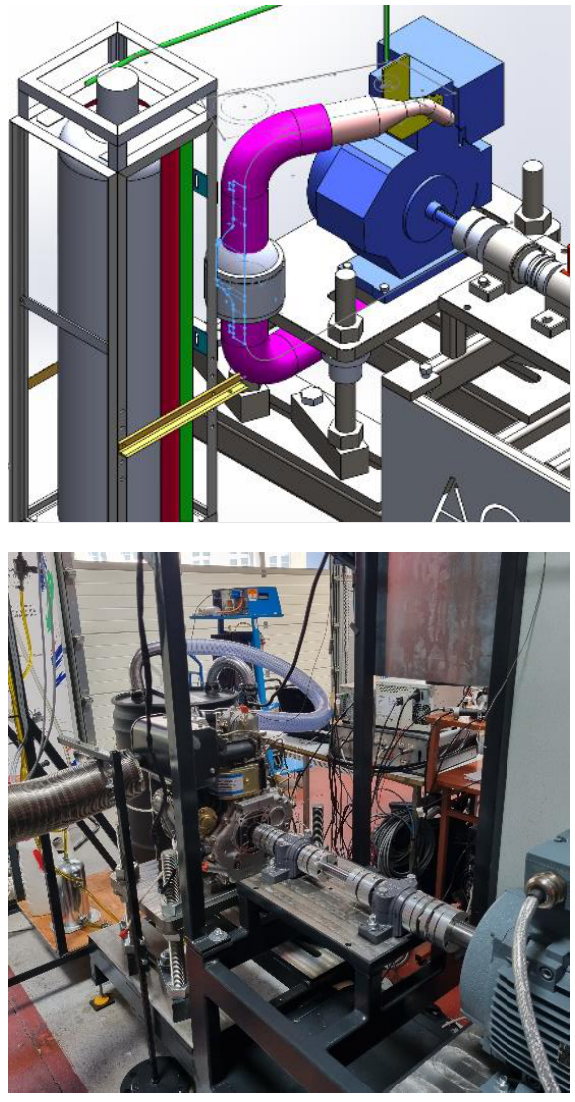
Fig. 1. Laboratory setup of design stage test rig (top) and manufactured test rig (bottom) The measurement bases were as follows: axis of engine shaft, front plate of engine (the beginning of shaft) and mounting (bottom) plate. Those are not subdued to any (planned) changes and cooperating parts can be easily ac- customed.